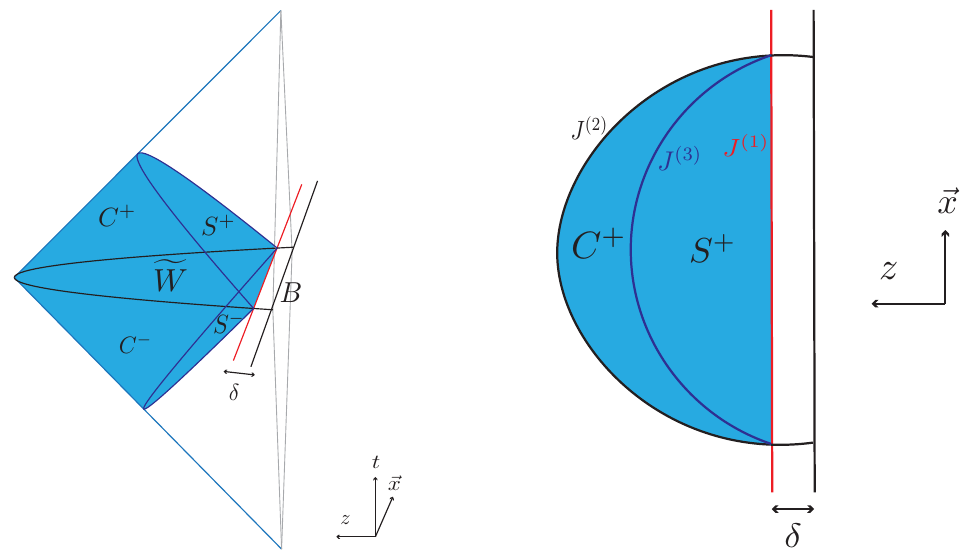
Figure 26 . The intersection of the entanglement wedge and the WDW patch de(cid:12)nes the region f W that is relevant for the evaluation of C A ( B